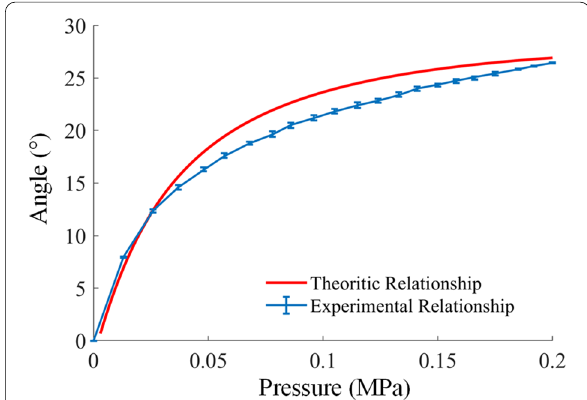
Figure 7 Relationship between the rotation angle of the wrist and the inflation pressure of the RSPA